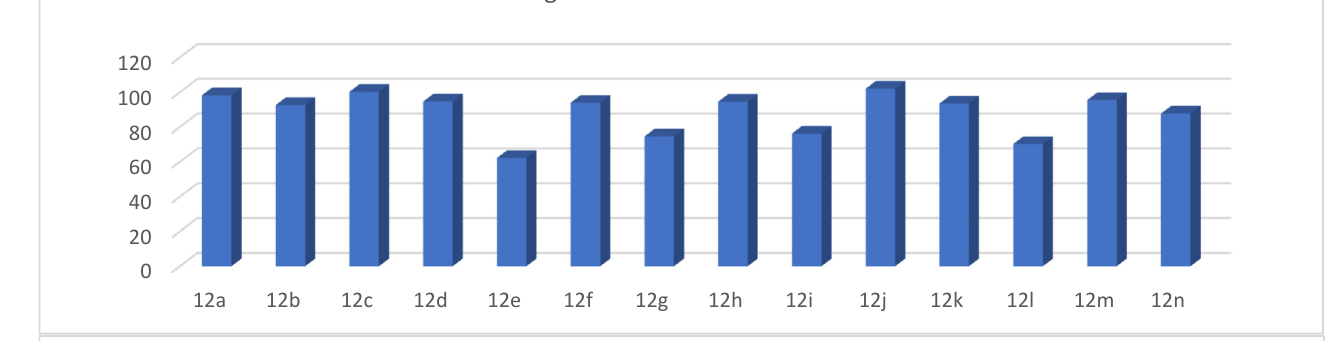
E: Mean groth % over Ovarian cancer cells